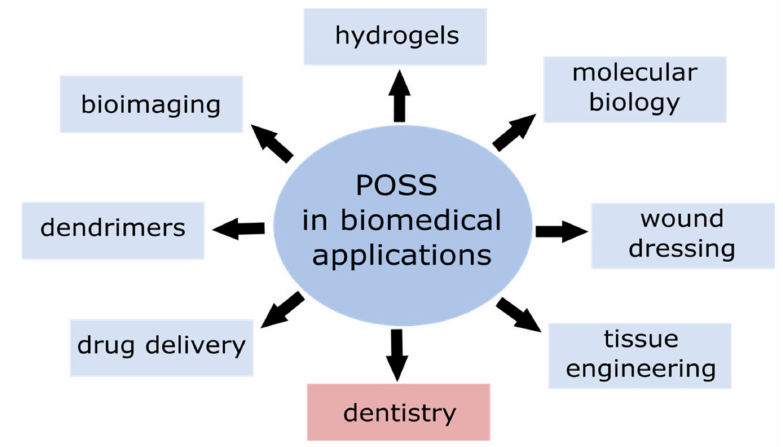
Figure 2. Possible applications of POSS in biomedical